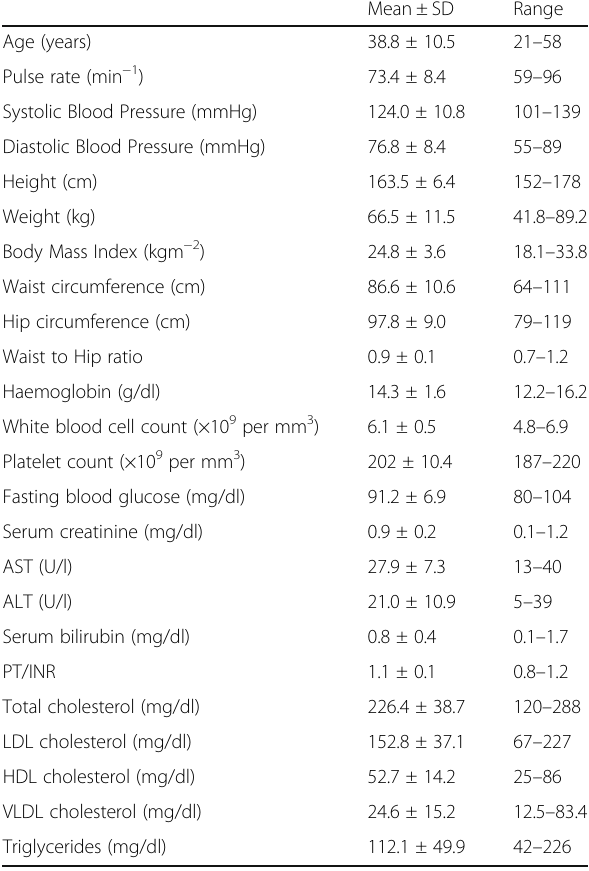
Table 2 Baseline characteristics of the study